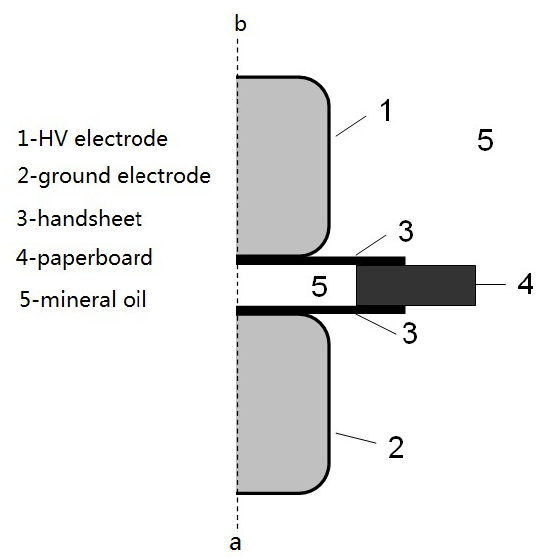
Figure 5. Computational domain.